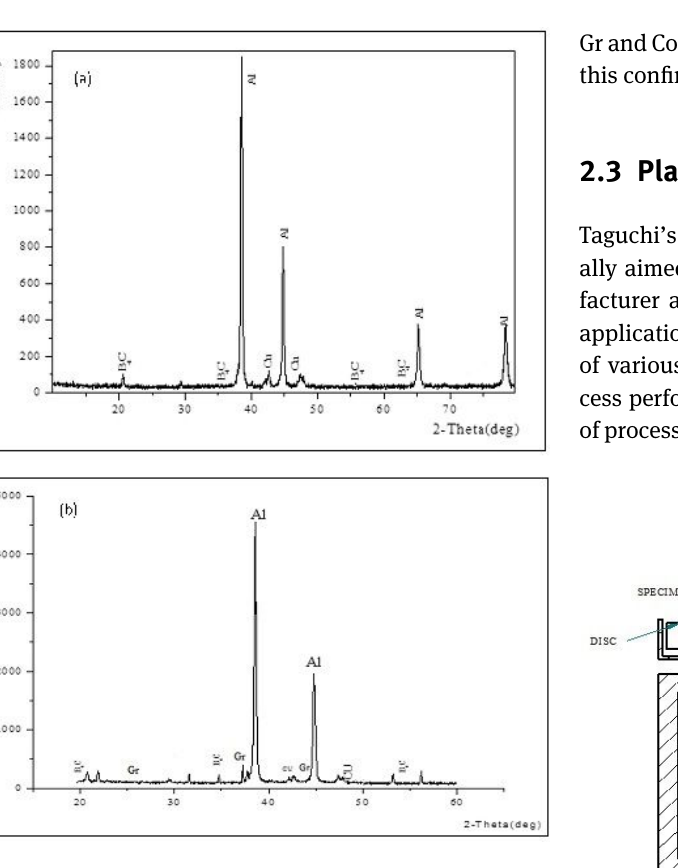
Figure 2: XRD profiles of (a) mono composite (Al2219+8% B 4 C); (b) hybrid composite (Al2219+8% B 4 C+3% Gr) along with B 4 C particles in Al matrix material as seen in Figure 1(c). The confirmation of B 4 C and Gr particles in